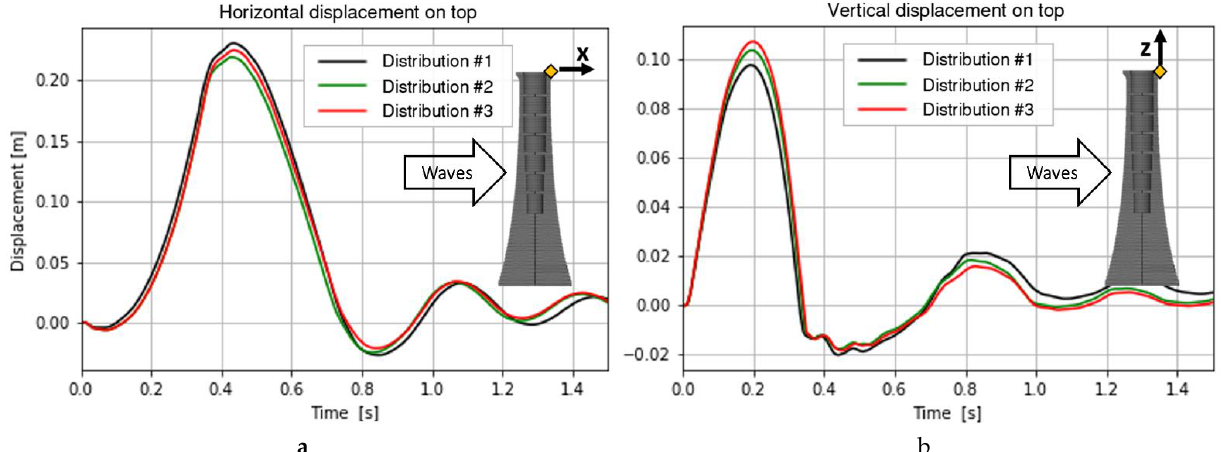
Figure 8. Structural response for the three distributions: ( a ) horizontal displacement; ( b ) vertical displacement.